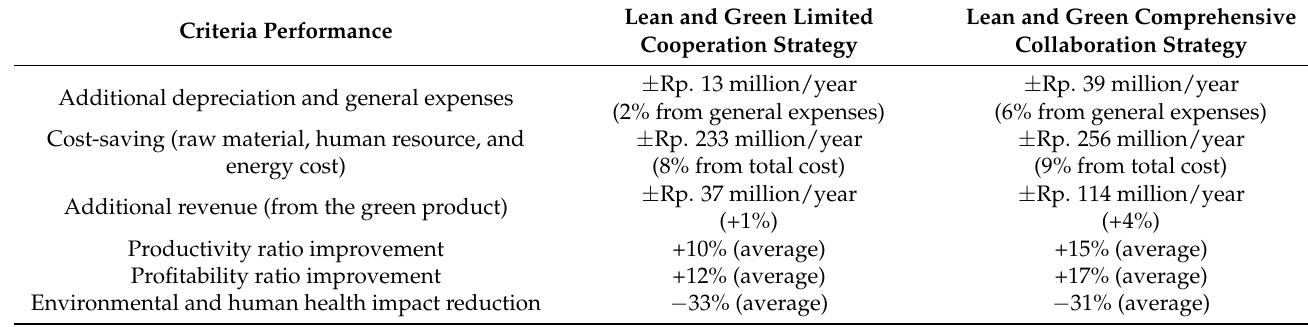
Table 2. Criteria performance comparison between limited cooperation and comprehensive collaboration strategies.